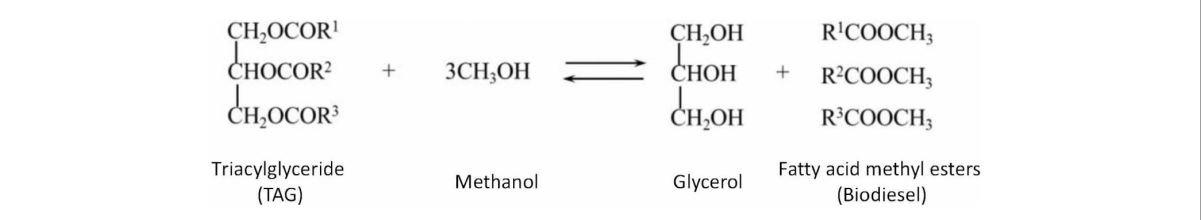
FIGURE6 Triacylglyceride (TAG) is used to synthesize biodiesel through transesterification.